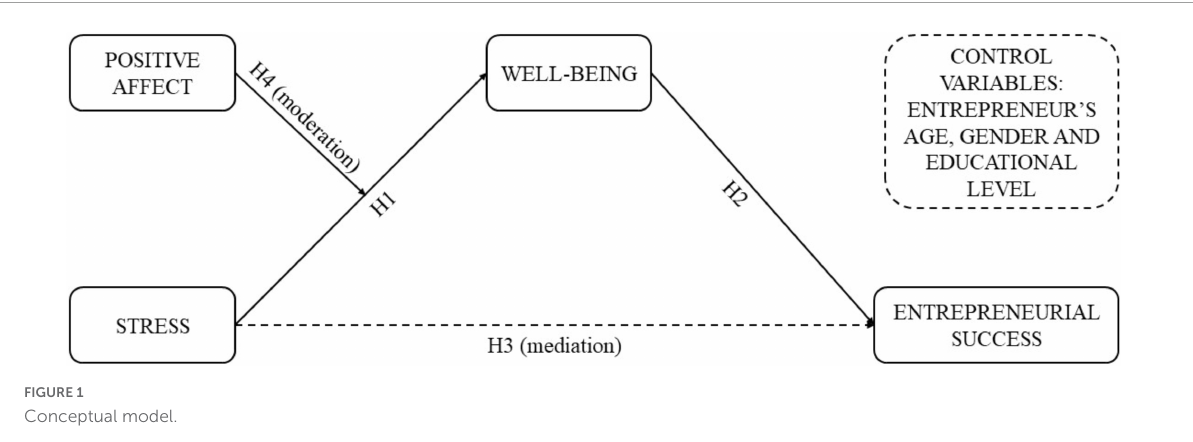
FIGURE1 Conceptual